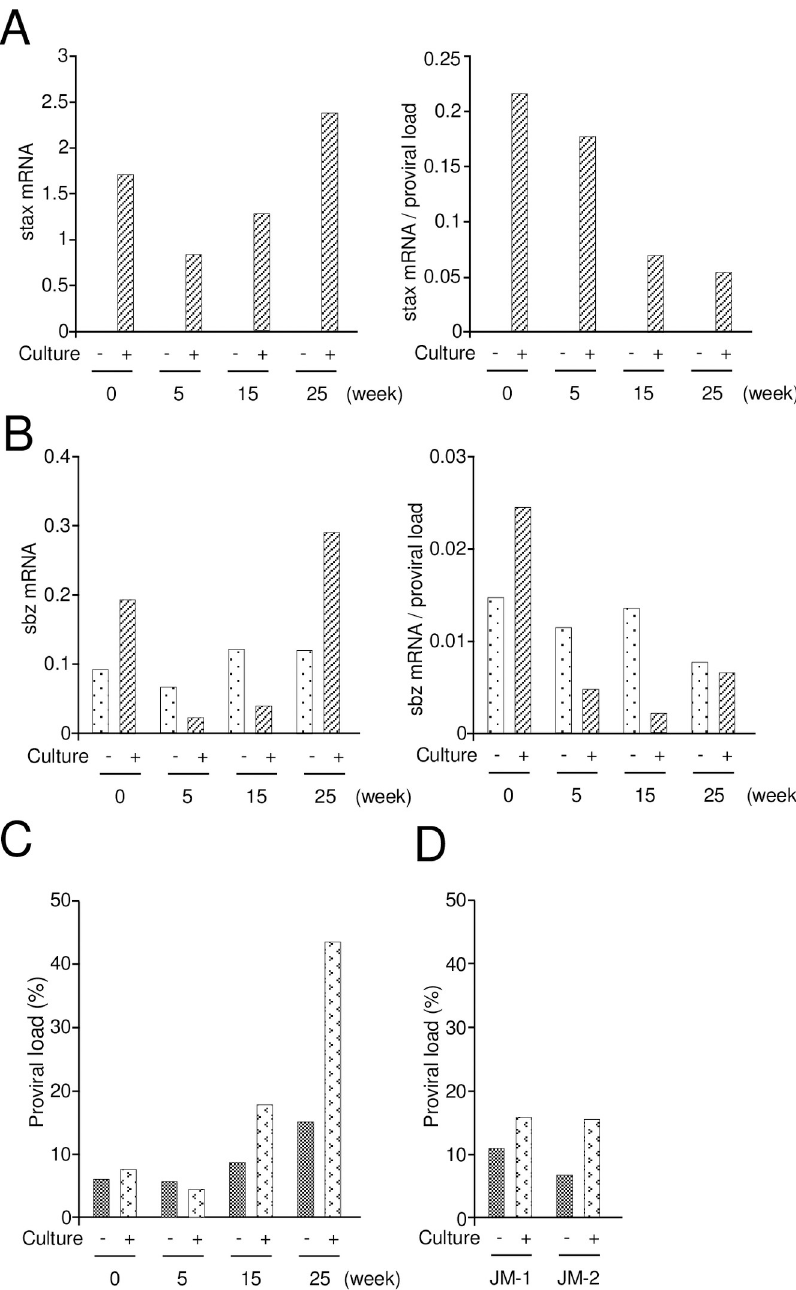
Fig 4. stax and sbz expression, and proviral load in the CD8 + -depleted Japanese Macaque. The expression level of stax and sbz in CD8 depleted Japanese macaque was measured by quantitative PCR, with (striped) or without (dotted) in vitro culture (24 hrs). Expression of CD4 + CD8 - T cells is shown in the left. The relative expression level per provirus is shown in the right: (A) stax transcripts, (B) sbz transcripts. (C) PVL before and after in vitro culture was measured in each sample. (D) PVLs were measured in two STLV-1 naturally infected Japanese macaques (JM-1, 2) without anti- CD8 antibody as